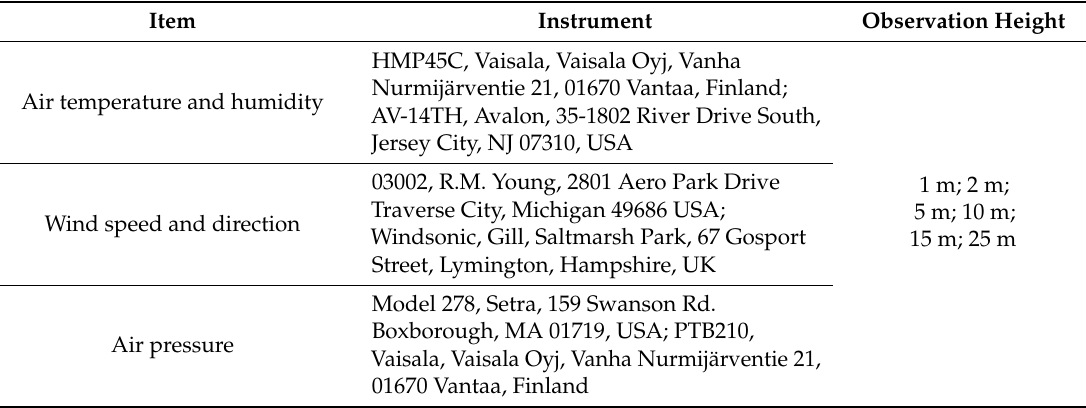
Table 1. Observed quantities and instrumentation at A’rou superstation